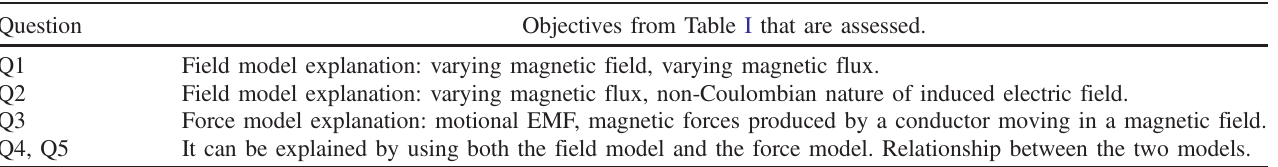
TABLE II. Relations between questions and objectives of the teaching sequence. Question Objectives from Table I that are